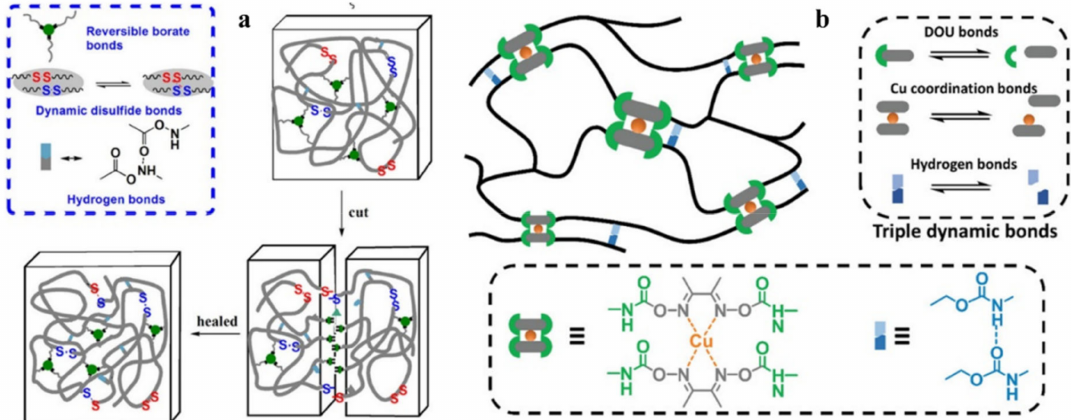
Figure 59. ( a ) Schematic diagram of the PU healing mechanism. Reprinted with permission from [242]. Copyright (2020) American Chemical Society. ( b ) Schematic structure of an elastomer, where DOU is dimethylglyoxime. Triple dynamic bonds, including reversible covalent (green arc and gray stick), M–L (gray stick and orange circle) and H-bonds (blue polygons), built hybrid dynamic networks. Reproduced from [243] with permission from John Wiley and